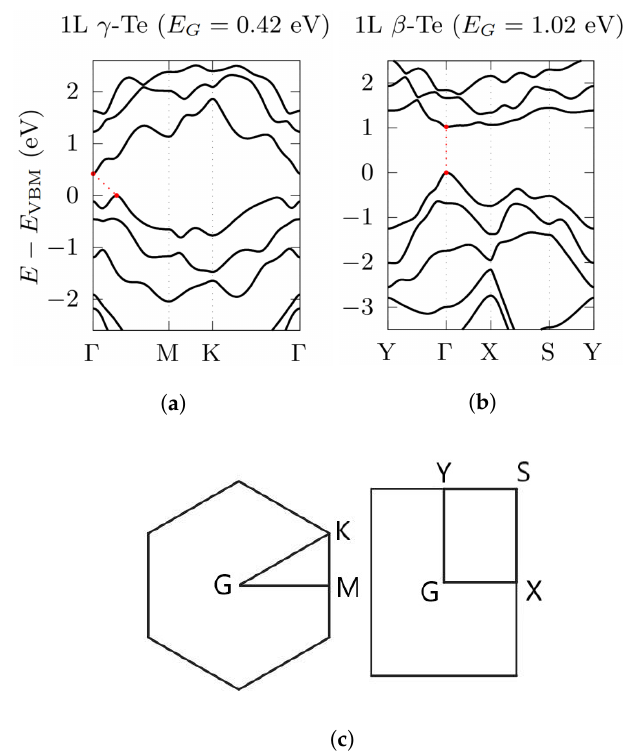
Figure 3. Electronic bandstructures, obtained by using a PBE functional, with the inclusion of SOC, for ML γ -Te ( a ) and β -Te ( b ). Energy rescaled with respect to the VBM. 2D hexagonal ( c , left ) and or- thorhombic ( c , right ) BZ, with the high symmetry points used in electronic bandstructure calculations. Regarding the γ -phase, the calculations were performed along the high-symmetry directions Γ → M → K → Γ in the hexagonal 2D BZ (Figures 3 and 5). In this case, the inclusion of SOC does not modify the nature of the gap, which remains indirect, but still moves the position of the VBM from the K → Γ to the Γ → M direction, with the CBM remaining fixed at Γ , except for 4L γ -Te, which apparently undergoes a semiconductor-to- metal transition, with the conduction band exceeding the valence band at Γ . In